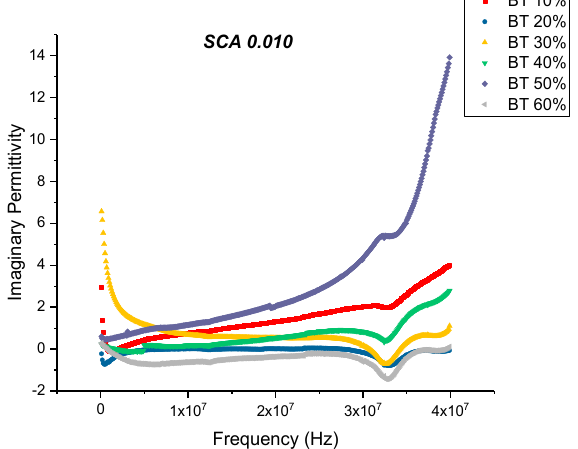
Figure 7. The dielectric loss of the BaTiO 3 -epoxy composite that were fabricated using BaTiO 3 nanoparticles which were surface modified using 0.010 SCA is plotted as a function of frequency where the volume fraction of BaTiO 3 is varied from 0.1 to 0.6. The maximum value is 2.05 for BaTiO 3 at 0.5 volume fraction. The imaginary permittivity increases with increasing volume fraction of BaTiO 3 nanoparticles and increases with increasing frequency. With increasing frequency, there are fewer contributing factors to the real permittivity do the delayed response of these orientations.